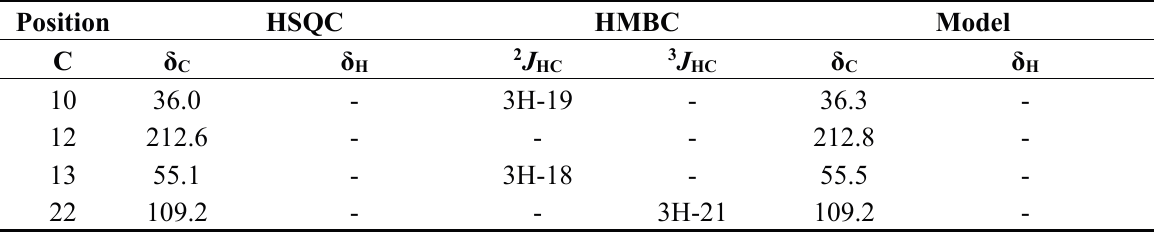
Table 1. 1 H (500 MHz) and 13 C (125 MHz) NMR data for 5 including results obtained by heteronuclear 2D shift-correlated HSQC (Heteronuclear Single Quantum Correlation) and HMBC (Heteronuclear Multiple Quantum Correlation), in pydine- d 5 as solvent and Tetramethylsilane (TMS) used as internal reference. Chemical shifts ( δ , ppm) and coupling constants ( J , Hz, in parenthesis).